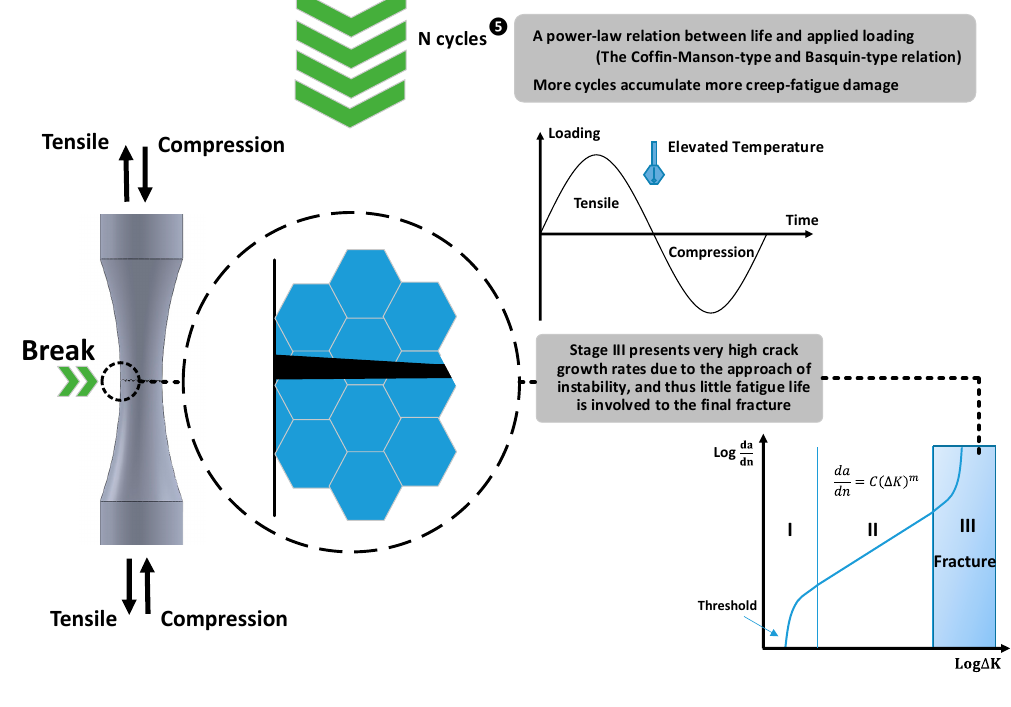
Figure 20. Structural failure.